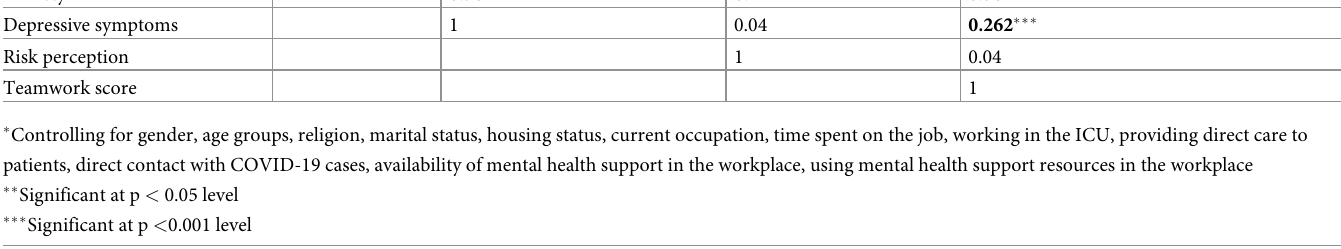
Most of our participants, 87.1%, lived with their families; this is in line with the study of Ghaleb et al. (Eastern Mediterranean Region) [18], in which the proportion of participants who lived with their families was about 78.2%. According to our results, most participants were married (50.4%), in agreement with the literature (69.4% and 59.9%) as stated in Arafa et al. (Egypt and Saudi Arabia) [30] and Ghaleb et al. (Eastern Mediterranean Region) [18] studies, respectively. Most participants in our sample were pharmacists (33%) or physicians (22.1%). In comparison, most participants were physicians (48.4%, 47%, and 34.9%) in the studies by Arafa et al. (Egypt and Saudi Arabia) [30], Alamri et al. (Saudi Arabia) [31], and Ghaleb et al. (Eastern Mediterranean Region) [18] respectively. According to our results, most participants (43.2%) had a work experience of two to five years, similar to the results of Elsaie et al. (Egypt) [29], where the "0–5 years" group represented 62.2% of participants and to Arafa et al. (Egypt and Saudi Arabia) [30] where the "1–5 years" of work experi- ence group represented 44.4%. At the same time, Alamri et al. (Saudi Arabia) [31] showed that the "5–14 years" of work experience group represented the biggest group of the sample with 43.4%.